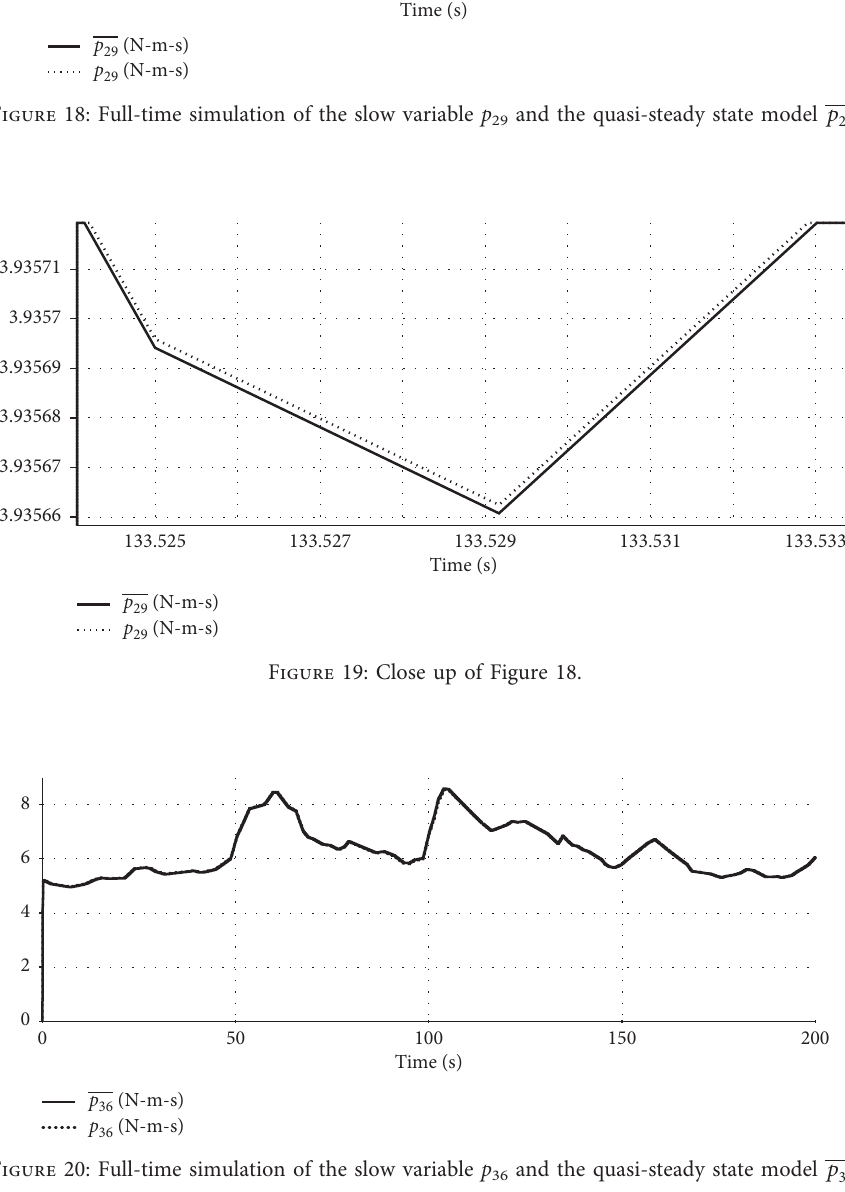
36 and the quasi-steady state model